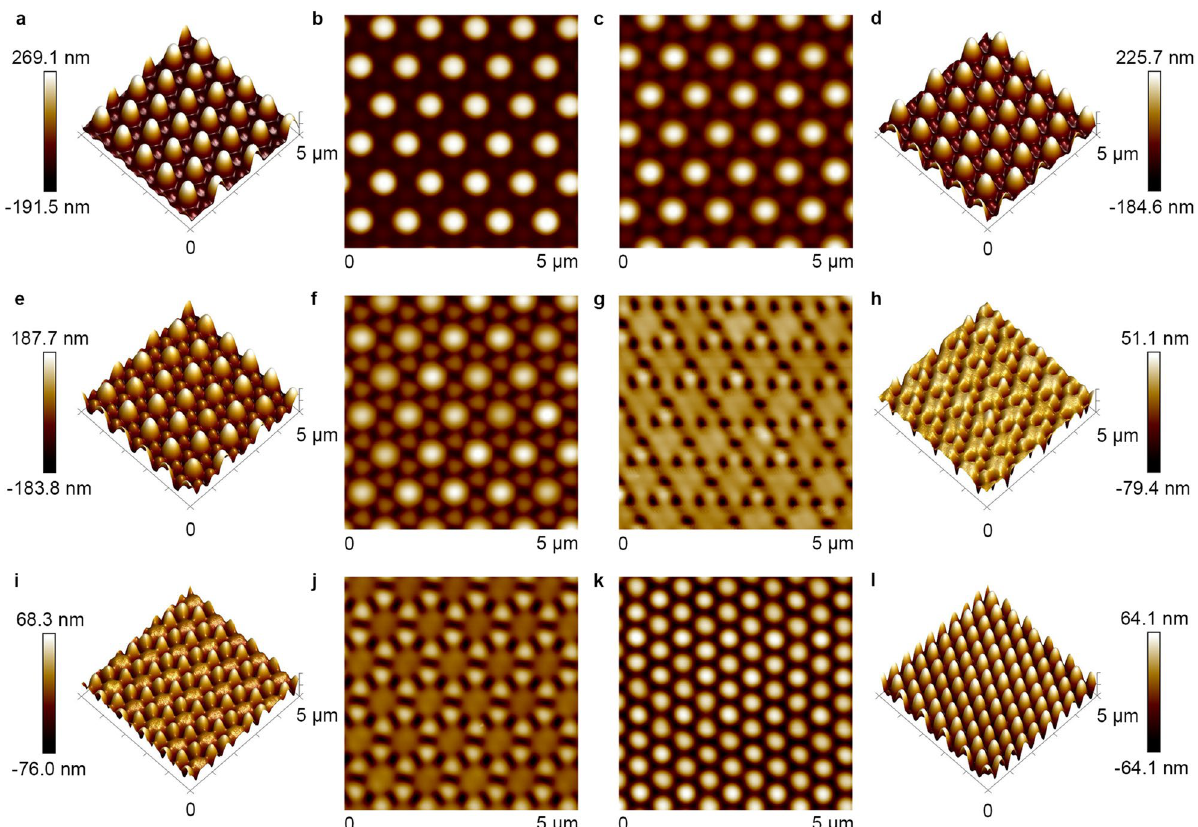
Figure 3. Typical AFM images of the IA-Chol submicron pillar arrays after irradiation with the right-hand circularly polarized light for different time periods. ( a, b ) 4 min. ( c, d) 6 min. ( e, f ) 8 min. ( g, h ) 10 min. ( i, j ) 14 min. ( k, l ) 30 min. The light intensity was 300 mW cm −2